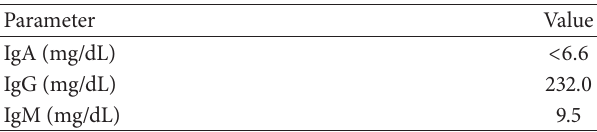
Table 2: Serum immunoglobulins